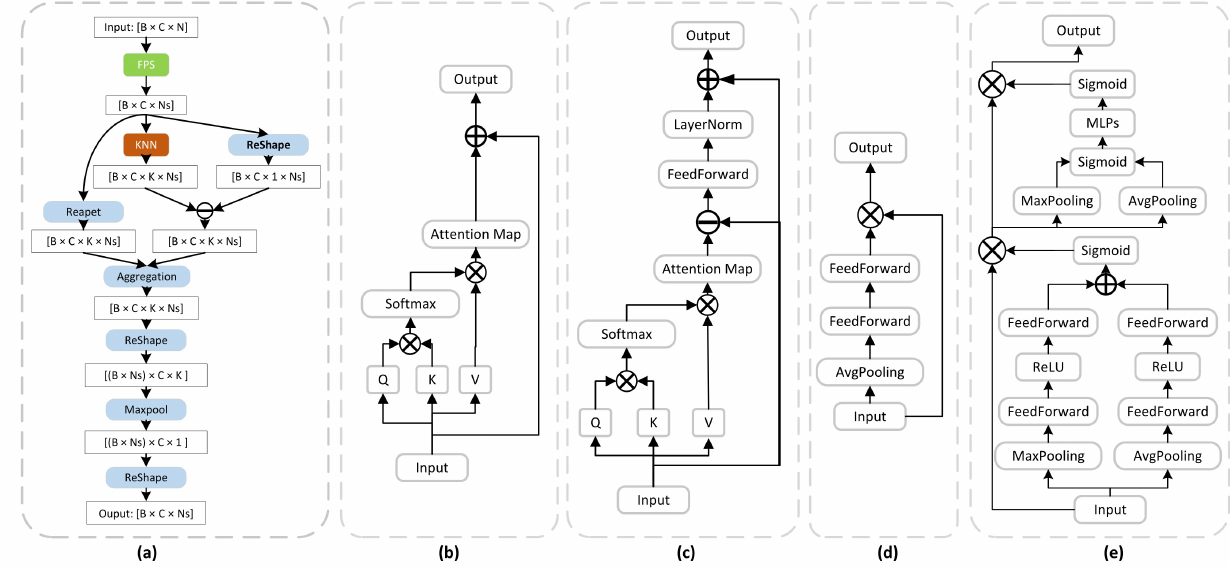
Figure 3. ( a ) Interactive Feature Fusion. ( b ) Point-Attention. ( c ) Offset-Attention. ( d ) Squeeze and Excitation (SE) block. ( e ) Convolutional Block Attention Module